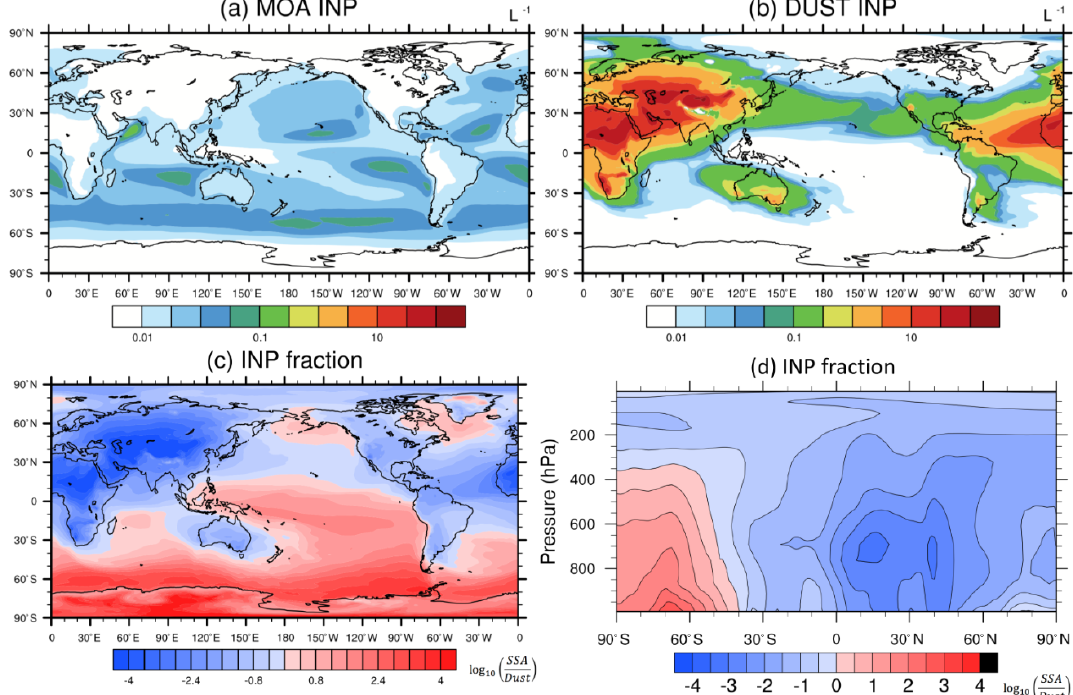
Figure 6. Spatial distribution of annual mean concentrations of (a) MOA INPs and (b) dust INPs, (c) the ratio of MOA INP concentration to dust INP concentration at 950hPa, and (d) vertical cross sections of the ratio of MOA INP concentration to dust INP concentration. INP concentrations are diagnosed at a temperature of − 25 ◦